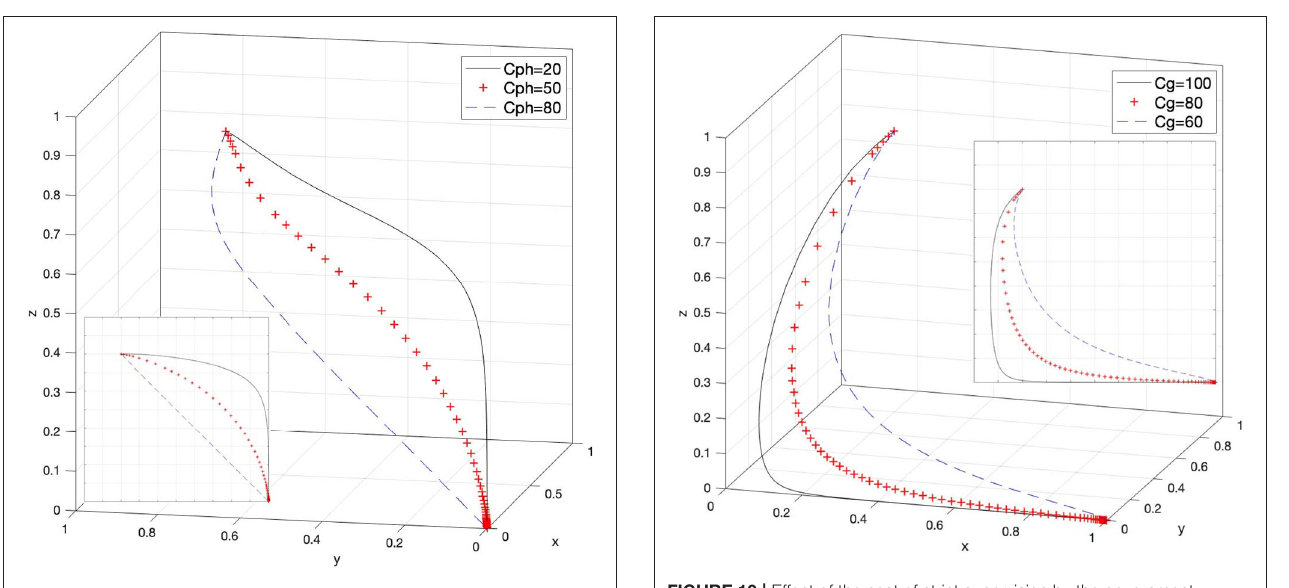
FIGURE 8 | Effect of the cost of docking between rights holders and e-commerce platforms.